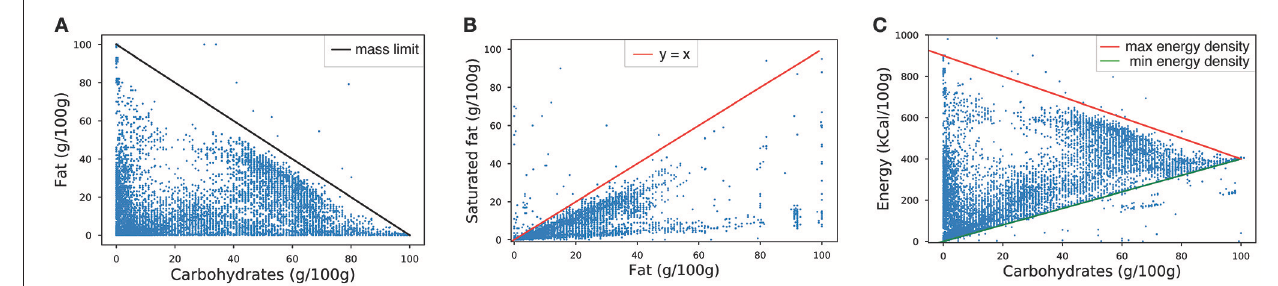
FIGURE 3 | Examples of tests implemented with linear boundaries on nutritional values. Dots outside the boundaries have been inspected and corrected whenever data were different from the products packages. Products in the fat/carbohydrates concentrations space (A) , saturated fat/fat concentrations space (B) and energy density/fat concentration space (C)